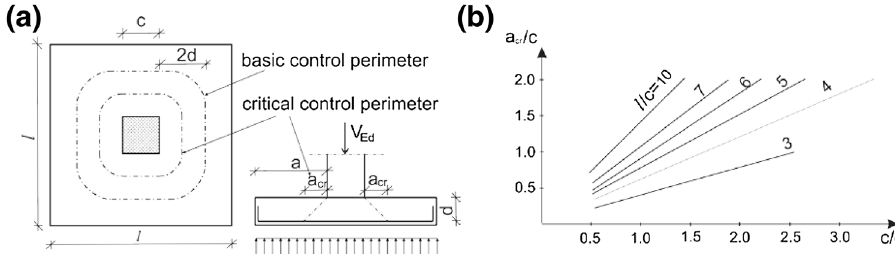
Fig. 10 Position of the basic and critical control perimeter: a according to EN 1992-1-1 (2004); b according to Eurocode 2—Commentary (2008) (critical